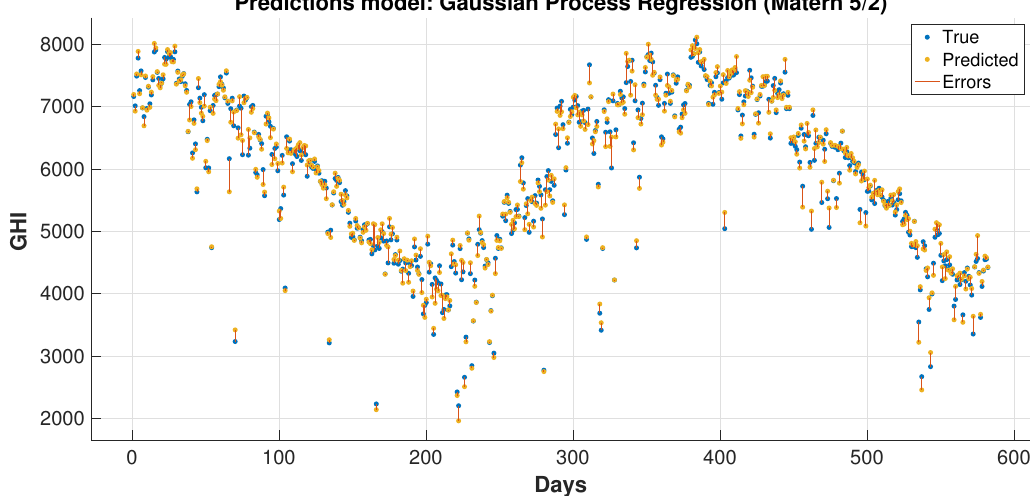
Figure 10. The predicted solar irradiance versus the real values for KAU dataset without reduction.